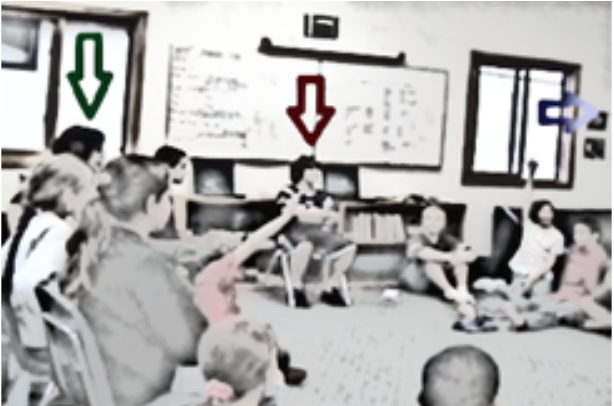
Figure 1: Group 3 Choices class (November 10, 2006): Overview of setting and